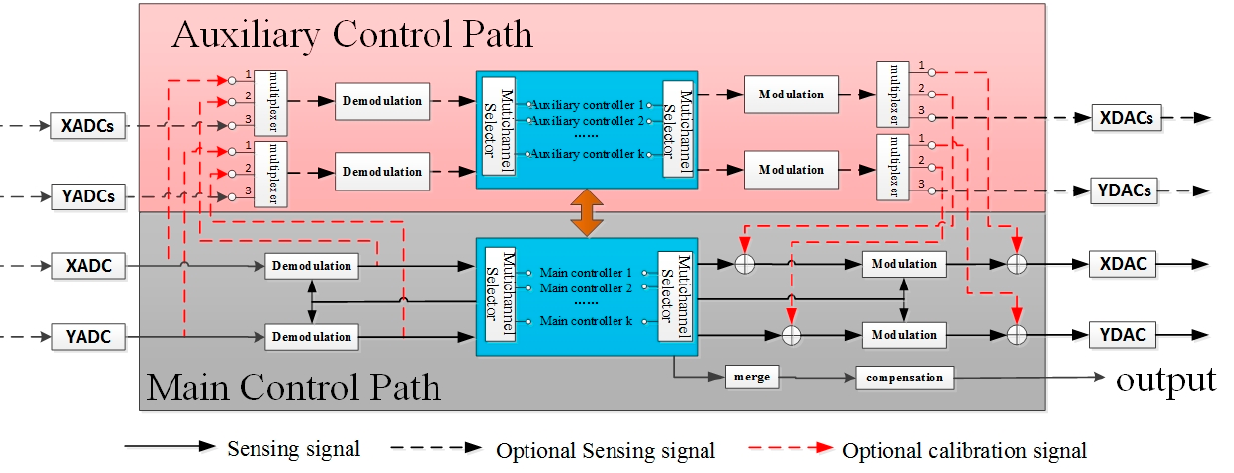
Figure 7. Schematic diagram of self-calibration algorithm.